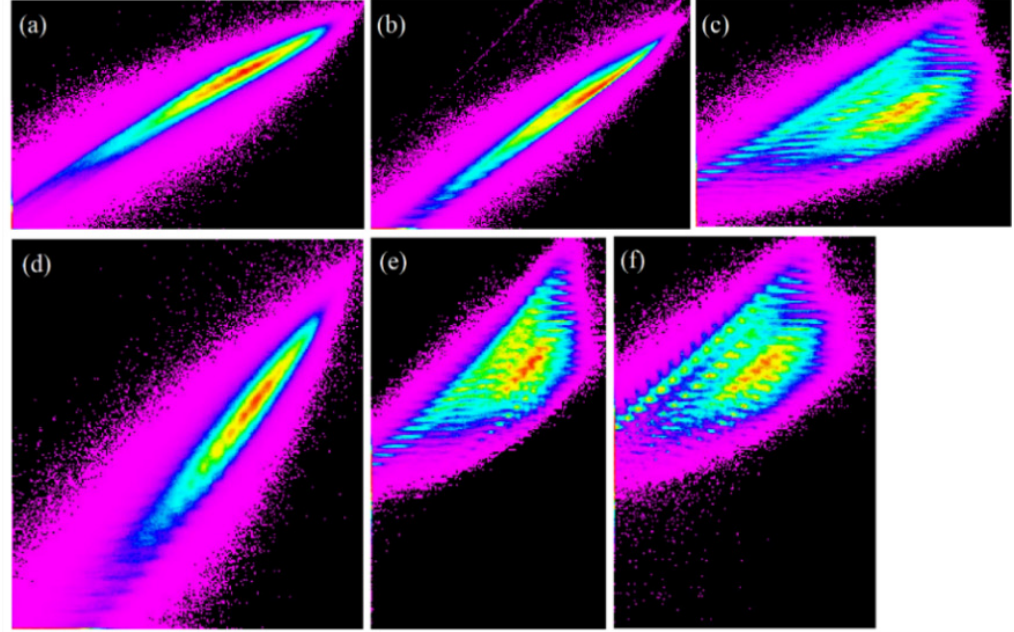
Figure 11. Scatterplot of ET on 5 August 2001 estimated using different ET models for grassland showing ( a ) METRIC model versus SEBAL model; ( b ) METRIC model versus SEBS model; ( c ) METRIC model versus SSEBop model; ( d ) SEBAL model versus SEBS model; ( e ) SEBAL model versus SSEBop model; and ( f ) SEBS model versus SSEBop model. Axes values are ET (mm) such as diagonal line will represent 1:1 line. Different colors in the scatterplots indicate density of points with red being the highest density and magenta being the least density.